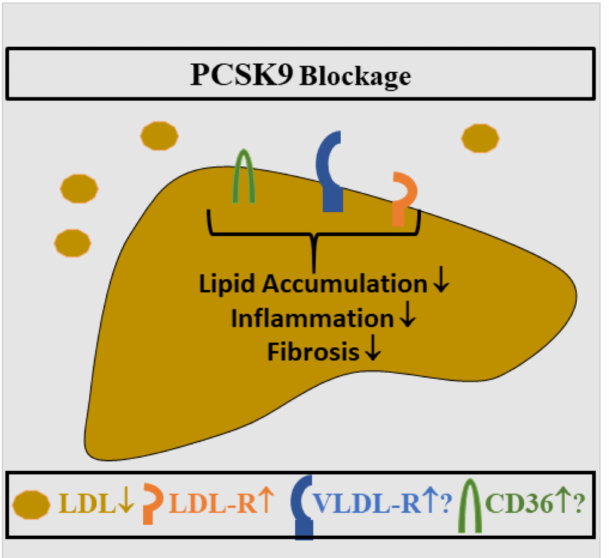
Figure 5. Role of PCSK9 in human liver steatosis. Therapy of severely hyperlipidemic patients with PCSK9 antibodies consistently improved liver steatosis, and a decline in liver inflammation and fibrosis was also observed. Circulating LDL levels were reduced in individuals treated with PCSK9 antibodies, suggesting higher expression of the hepatic LDL-R [153–155]. Whether this is associated with increased VLDL-R and CD36 levels needs further